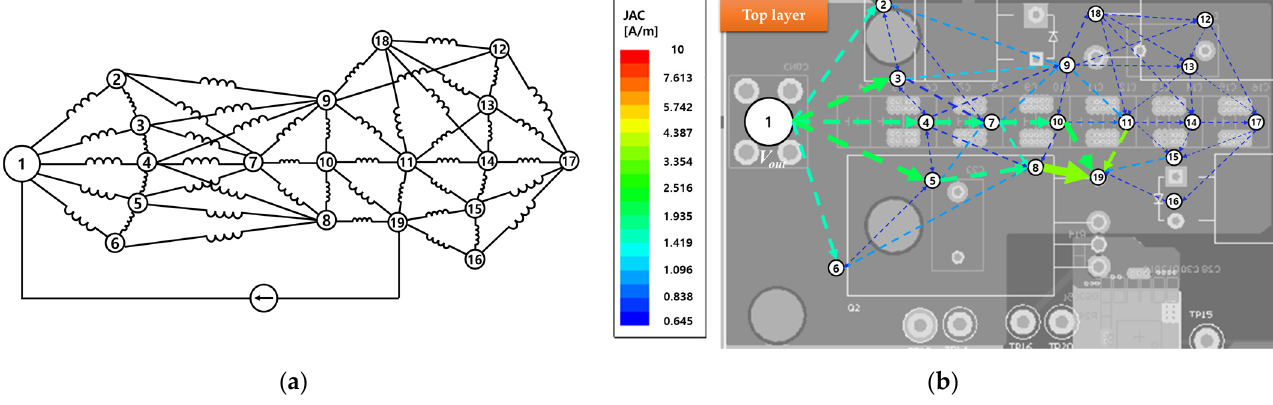
Figure 10. PSpice simulation at top layer. ( a ) Circuit model. ( b ) Simulation result.